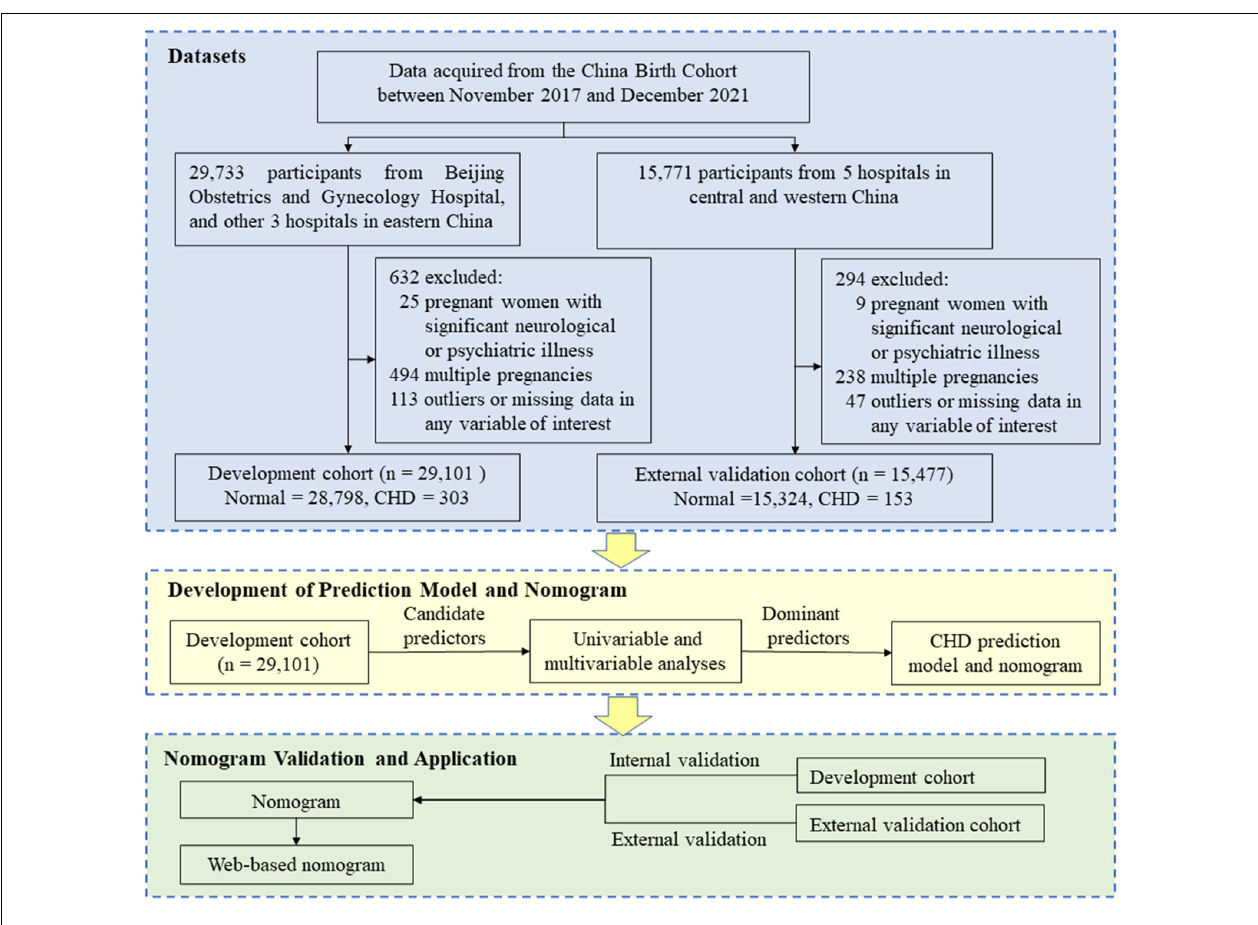
FIGURE 1 | Flowchart of the study. CHD, congenital heart